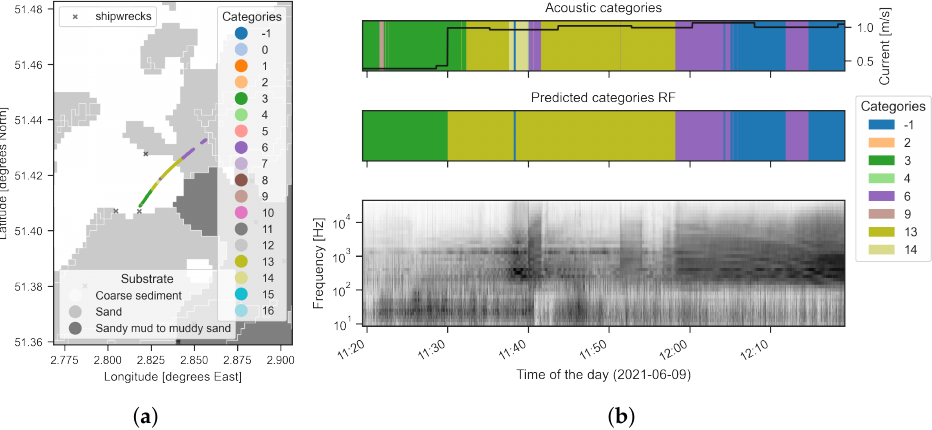
Figure 10. Zoom of one deployment recorded the 9 June of 2021: ( a ) plotted on top of a map of the substrate type; ( b ) plotted in